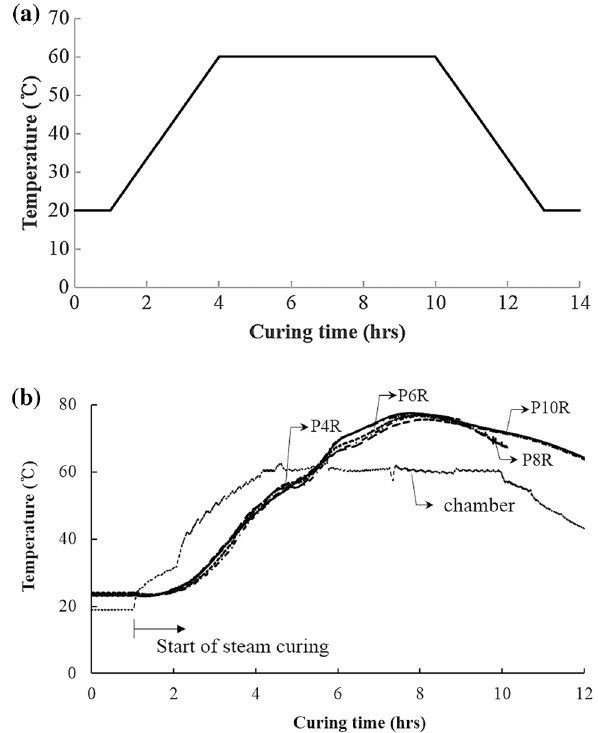
Fig. 4 Steam curing. a 3–6–3 h steam curing regime and b changes in the measured temperature inside cham- ber and concrete in the pull-out specimen.